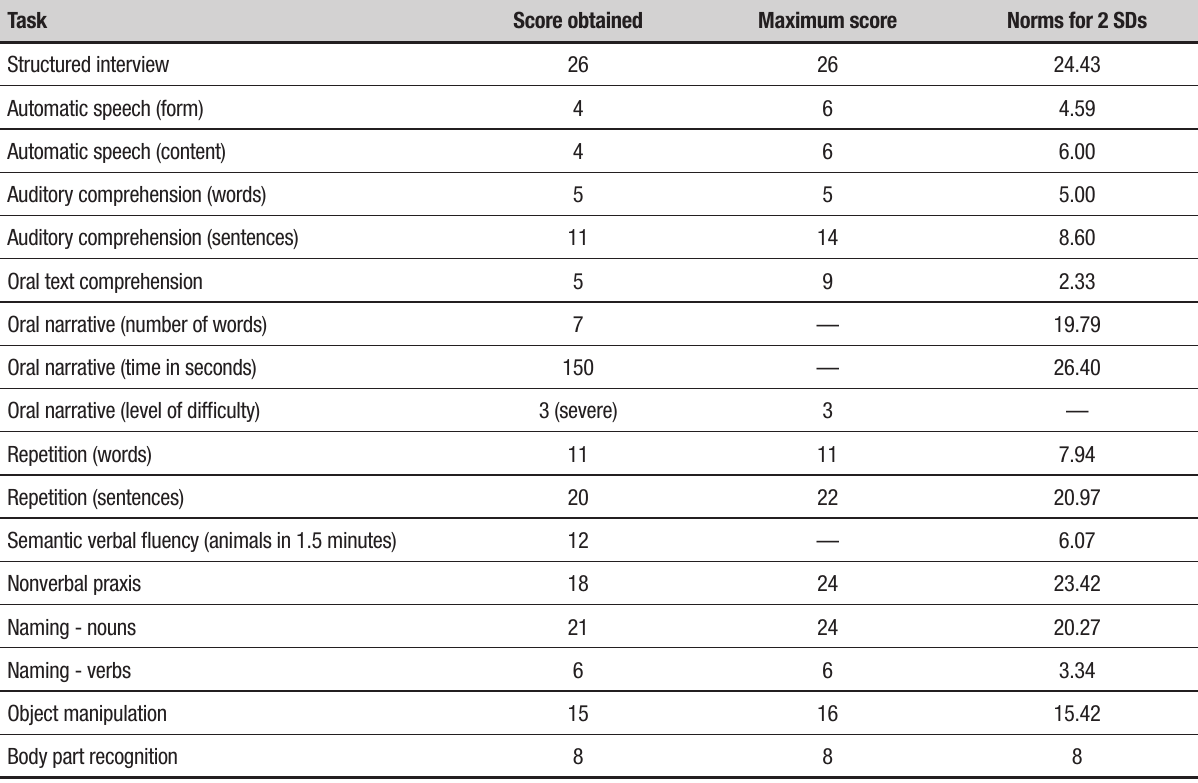
Table 1. Description of patient’s performance on language